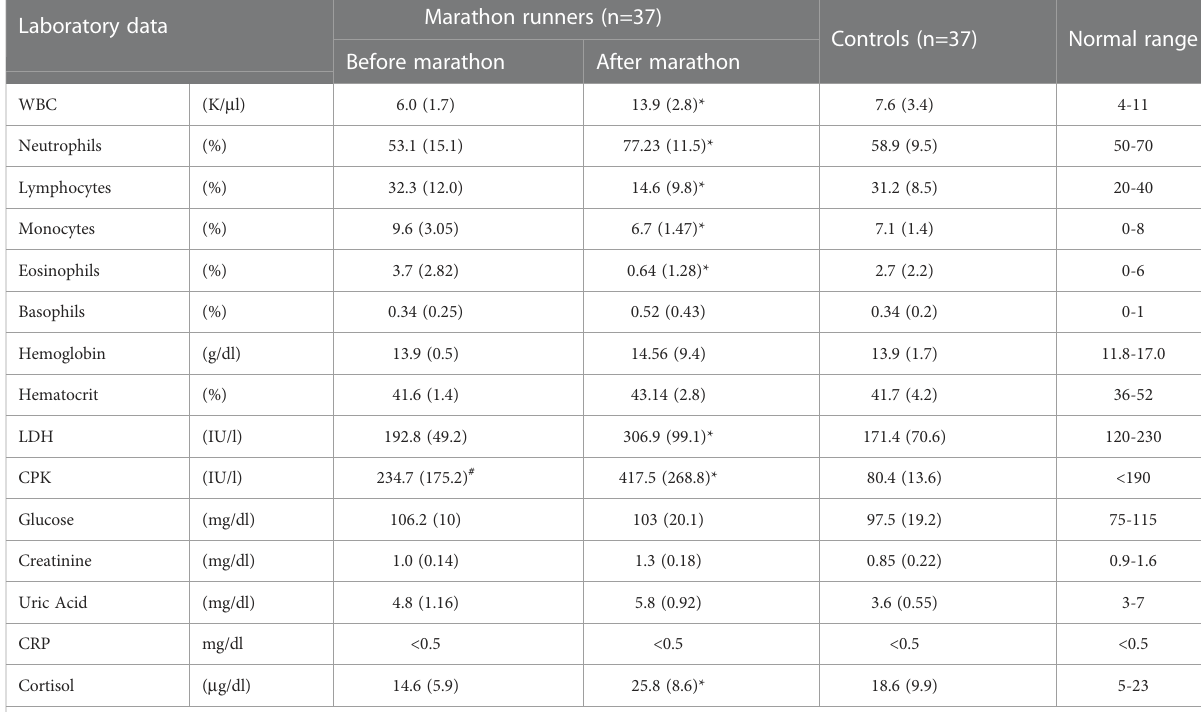
TABLE 3 Laboratory parameters of marathon